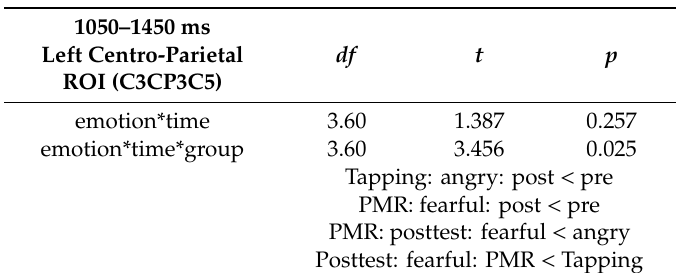
Figure 7. Event-related brain potentials (ERP) results. Positive polarity is plotted downwards. Table 3. ERP results from the ANOVA emotion*time*group for the time window 1050–1450 ms at the left centro-parietal ROI (region of interest). Following significant interactions, the significant post-hoc t -tests are reported below. x < y indicates a reduced positivity for x compared to y.